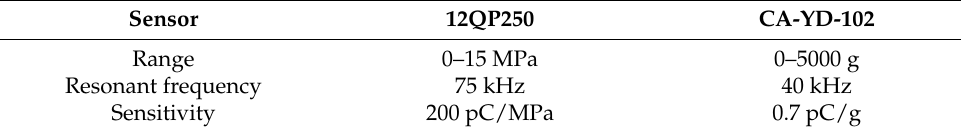
Figure 2. The schematic illustration of the test bench. Table 2. Specifications of pressure transducer and accelerometer.